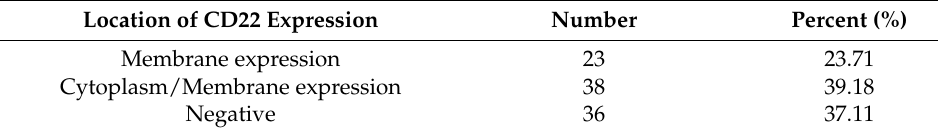
Table 1. Localization of CD22 in 97 TNBC Specimens.